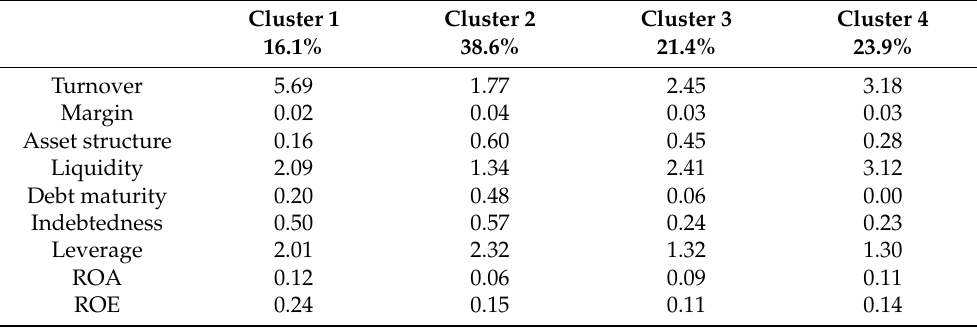
Table 6. Cluster centers: standard financial ratios computed from cluster geometric means. Weighted analysis.